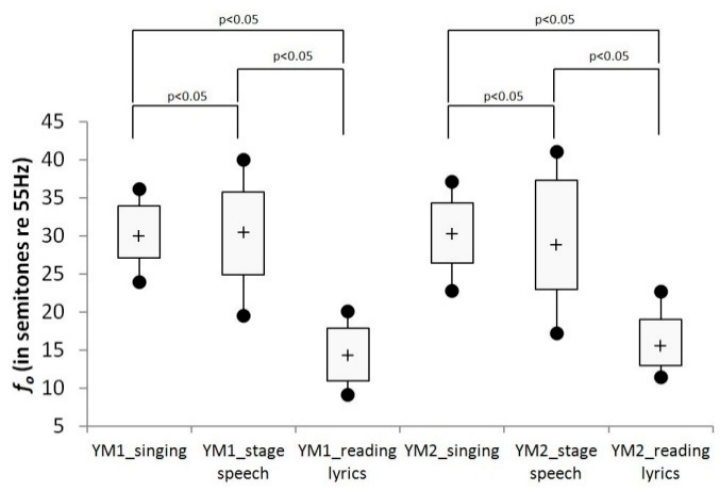
Figure 2. Box plot of f o .